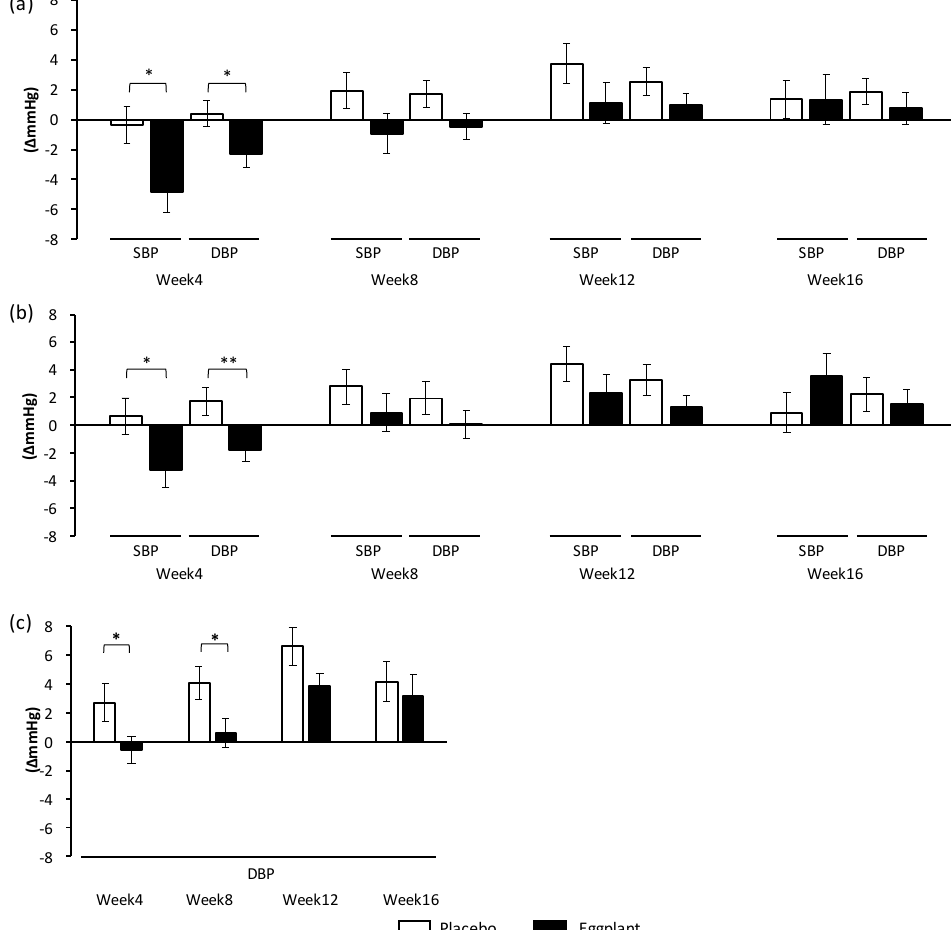
Figure 3. Changes in home BP (different values from week 0). ( a ) Morning SBP and DBP of all participants, ( b ) Morning SBP and DBP of participants with normal-high BP, ( c ) evening DBP of participants with normal-high BP. Student’s t -test was conducted for data analysis. Statistical significance: * p < 0.05 and ** p < 0.01 vs. placebo group. Values are presented as mean ± standard error. BP: blood pressure; DBP: diastolic blood pressure; SBP: systolic blood pressure.